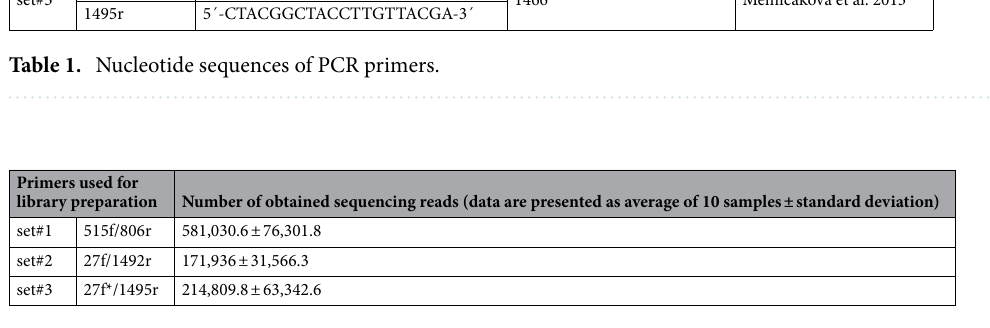
Table 2. Numbers of obtained sequencing reads.